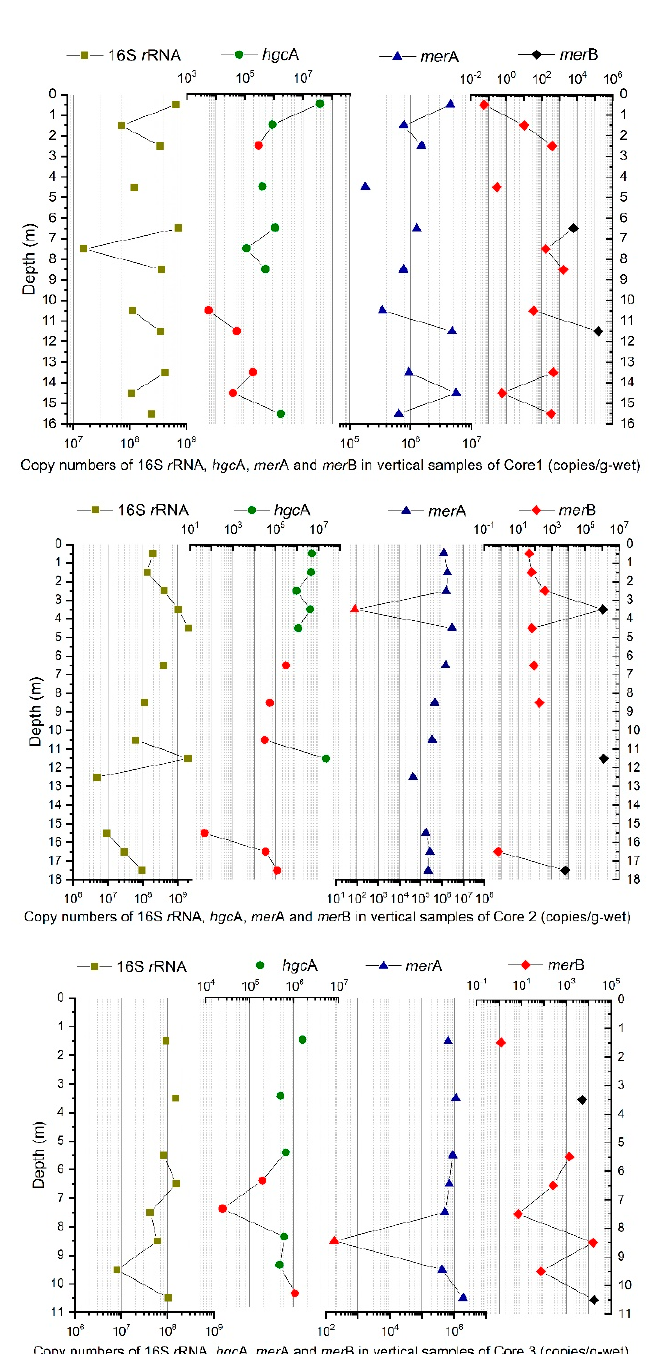
Figure 5. Transcripts abundance of 16S rRNA, hgcA, merA and merB in Core 1, 2 and 3; the red symbol indicates data that is below the detection limit, and that the results shown here are for reference.